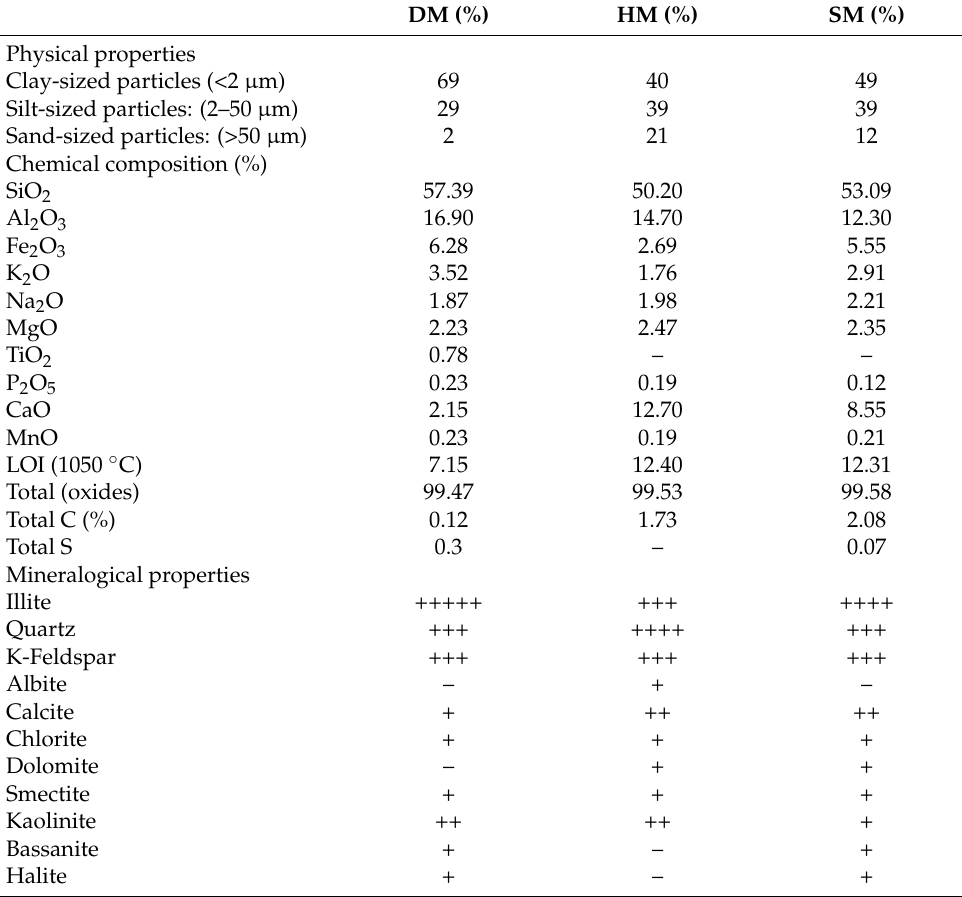
Table 2. Mineralogical and chemical composition (oxide content %) of the DM, HM, and SM